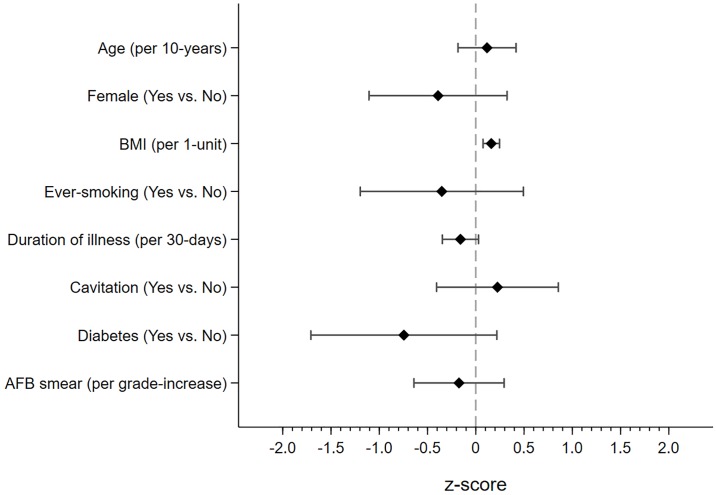
Difference in FEV1 z-score by participant characteristics at treatment initiation.Figure depicts point estimate and accompanying 95% confidence interval for FEV1 standardized by z-scores. Higher z-scores indicate better FEV1. Regression analysis was adjusted for age, sex, BMI, ever-smoking, duration of illness, cavitation, diabetes and smear grade. FEV1 —forced expiratory volume in the first second, BMI—body mass index, AFB—acid fast bacilli.